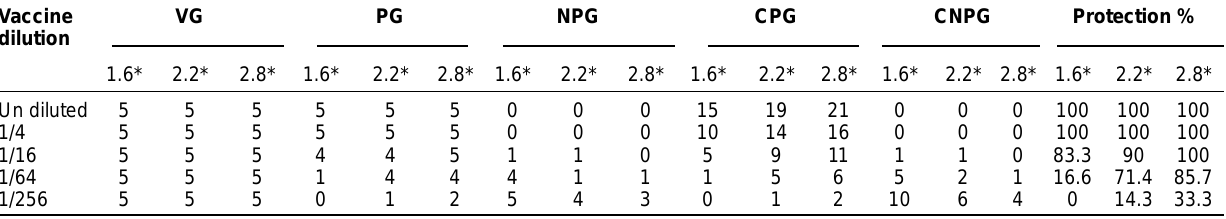
Table-4. GPPD of FMD virus type SAT2/EGY/2012 with different 146S content vaccine 50 Vaccine VG PG NPG